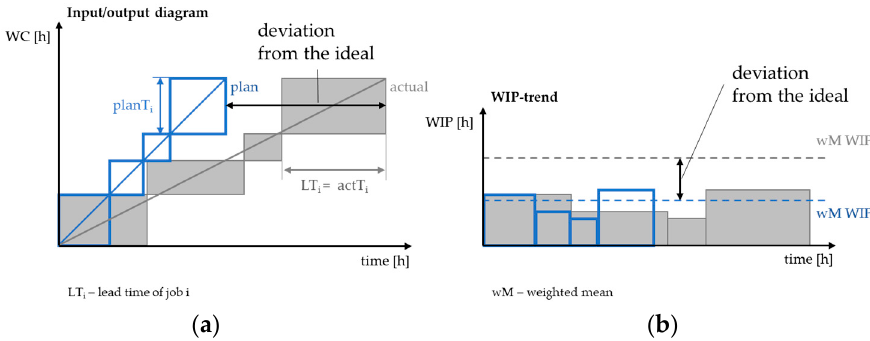
Figure 6. ( a ) Input/output diagram and ( b ) inventory development for a real process.